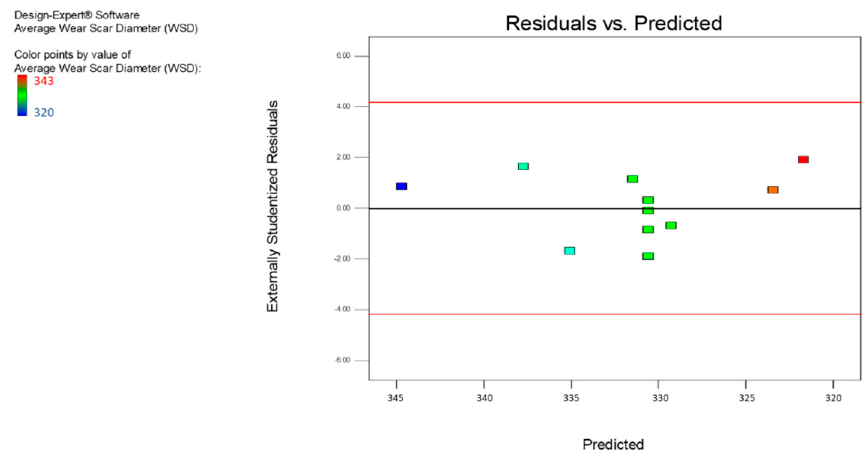
Figure 11. The residuals vs. the predicted average WSD for the MoS 2 nanolubricants.